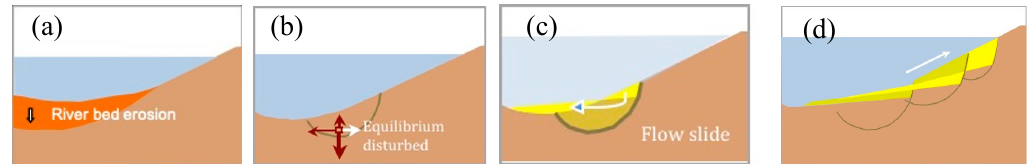
Figure 16. Sketch series of three flow slides at a revetment: ( a ) and ( b ): bank toe becomes unstable because of river bed erosion, ( c ): flow slide and ( d ): next flow slides part of retrogressive erosion. The outflow of pore water after a flood peak can also contribute to a failure, described for example by Coleman [3] and the BWDB manual [9]. This phenomenon starts with the inflow of river water into the subsoil by a negative difference in groundwater level and the water level in the river